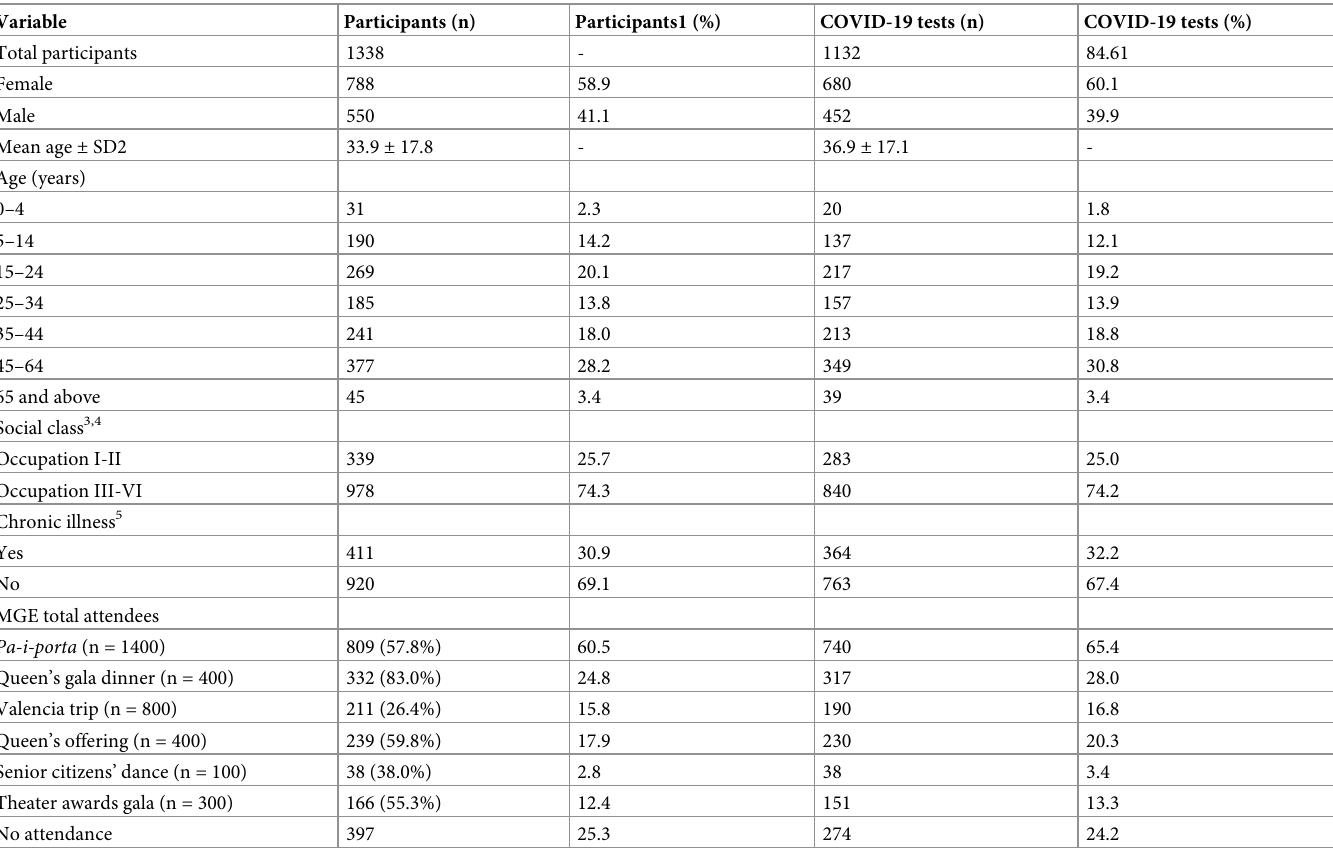
Table 2. Characterization of the participants included in the study of Mass Gathering Events (MGEs) from January 1 to June 31, 2020,